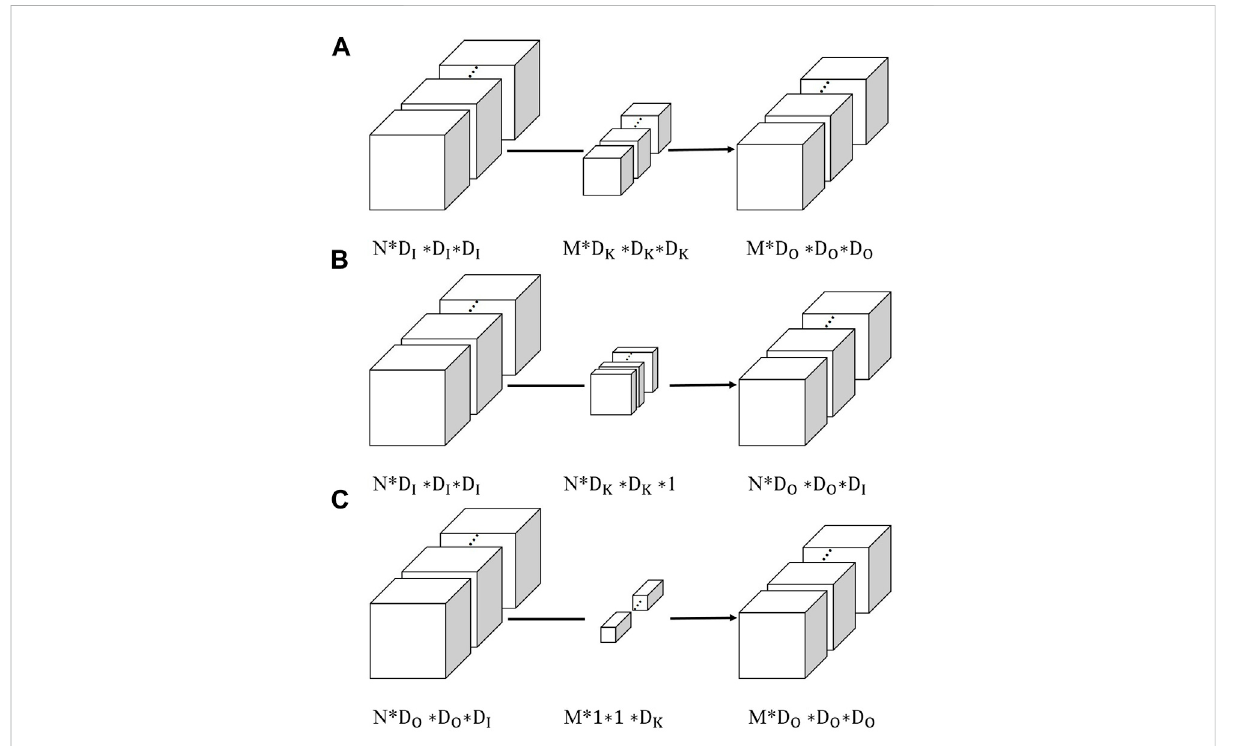
FIGURE 3 (A) Standard convolution; (B) depthwise convolution; and (C) pointwise convolution. N , M are the channel number of input and output.